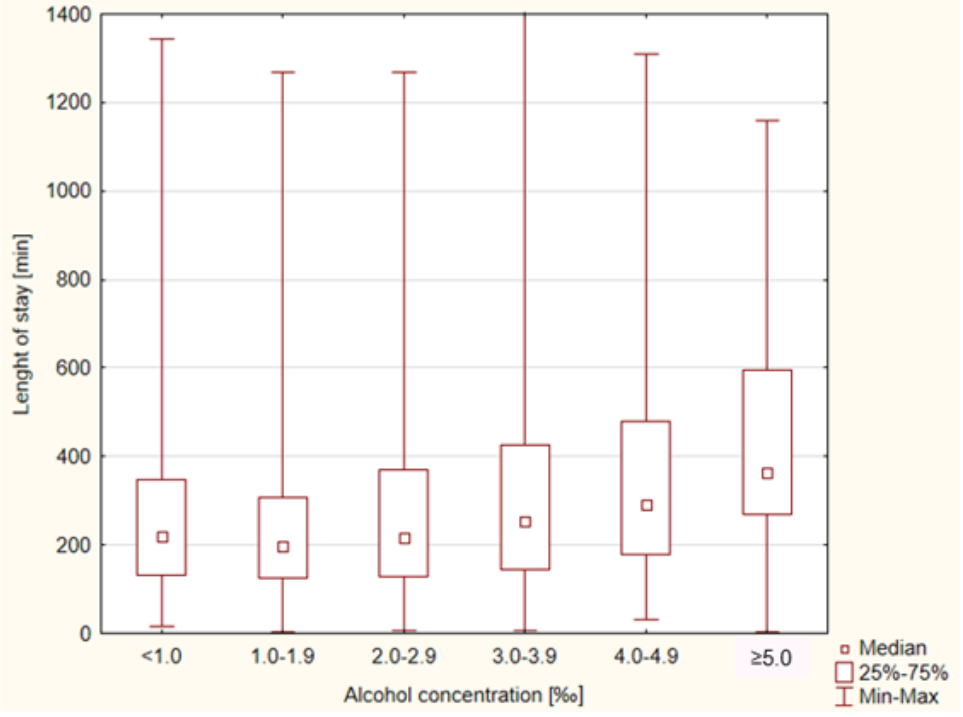
Figure 1. Median duration of patients’ stay in ED (measured in minutes) according to their measured blood alcohol concentration (BAC) 3.1.2. Admission Rate.